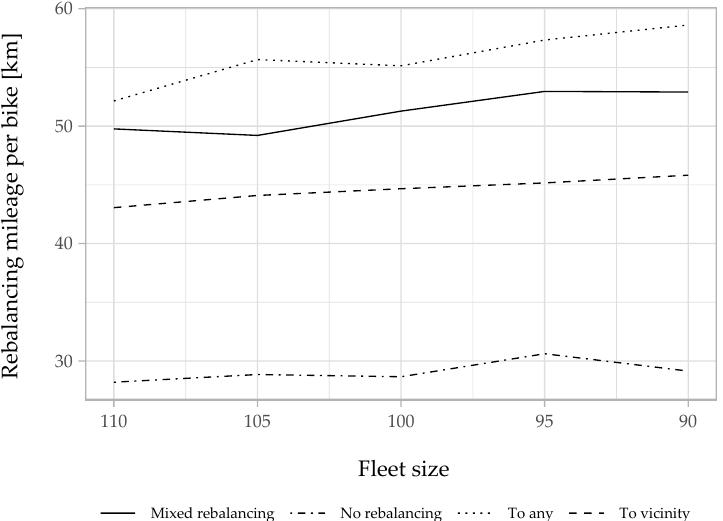
Figure 11. Rebalancing mileage traveled per bike for different fleet